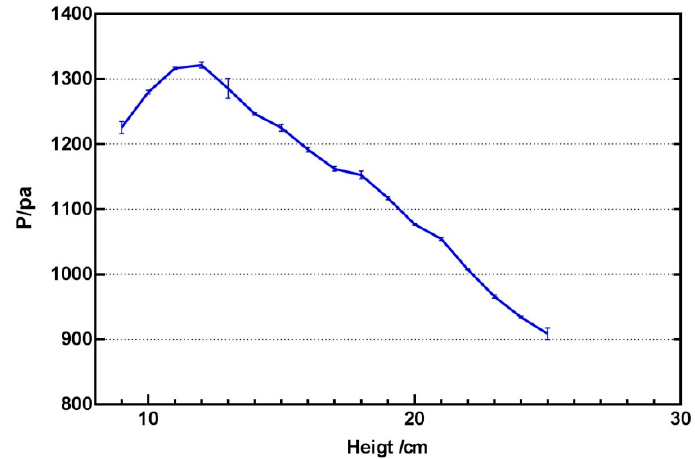
Figure 7. The relationship between height and output intensity.